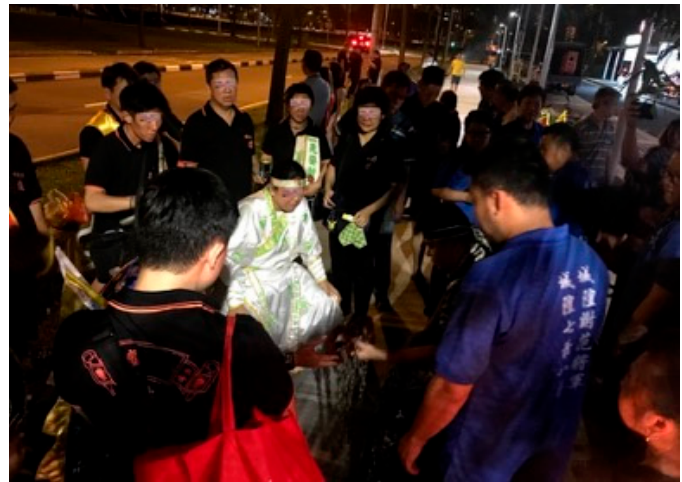
Figure 4. A Footpath being Appropriated by Two Sintuas for an “Ah Peh Party”. Temple assistants and devotees from both sintuas crowd around the deities to listen in on their conversations and to join in the religious merriment. The name of the sintua has been redacted, and the faces of people have been pixelated to protect their anonymity.